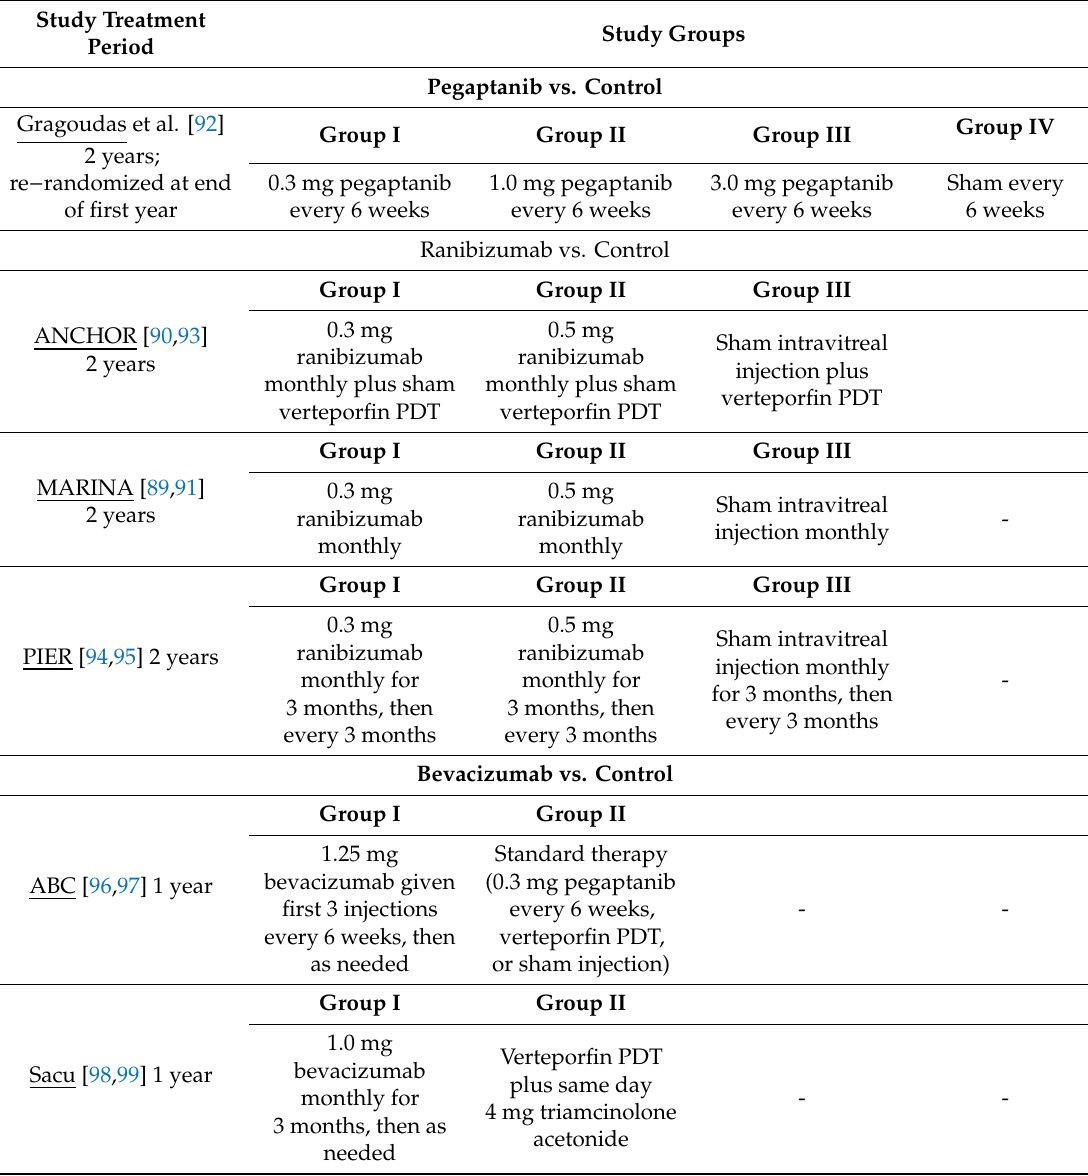
Table 1. Overview of the di ff erent studies evaluating the e ff ects of vascular endothelial growth factor inhibitors (anti-VEGF) in patients with age related macular degeneration (AMD). Study Treatment Study Groups Pegaptanib vs.